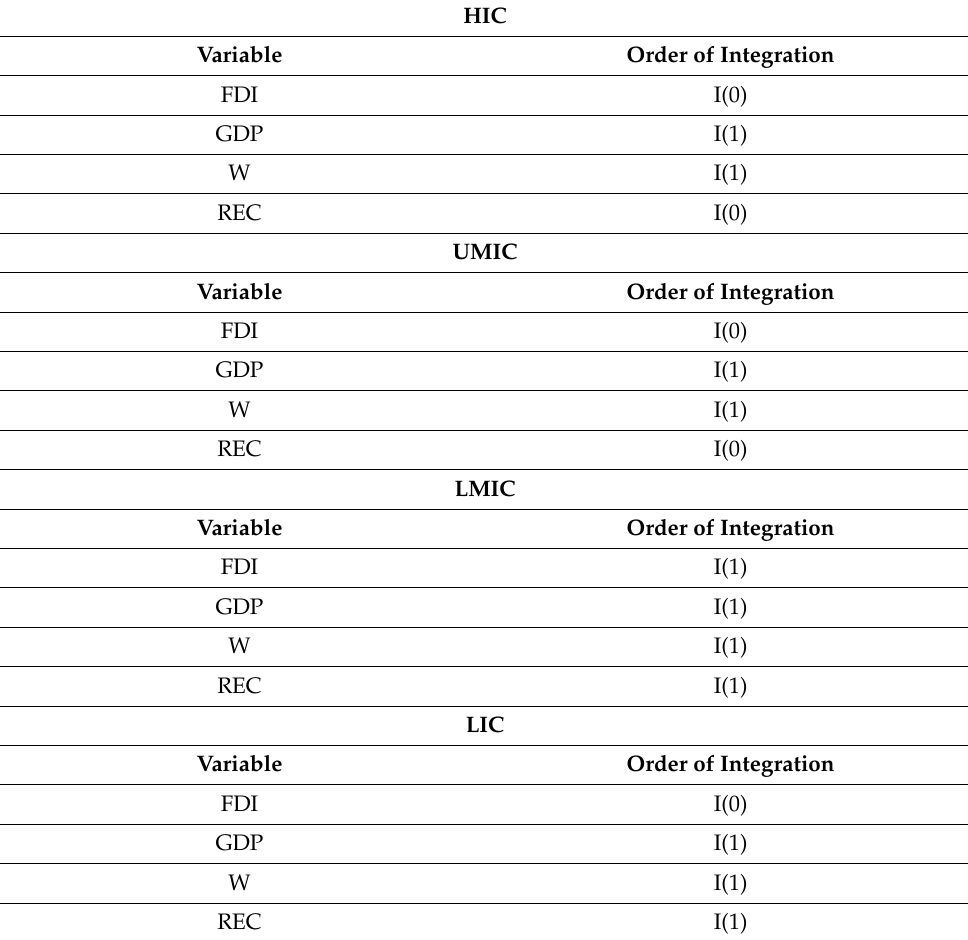
Table 4. Panel Unit Root Tests for